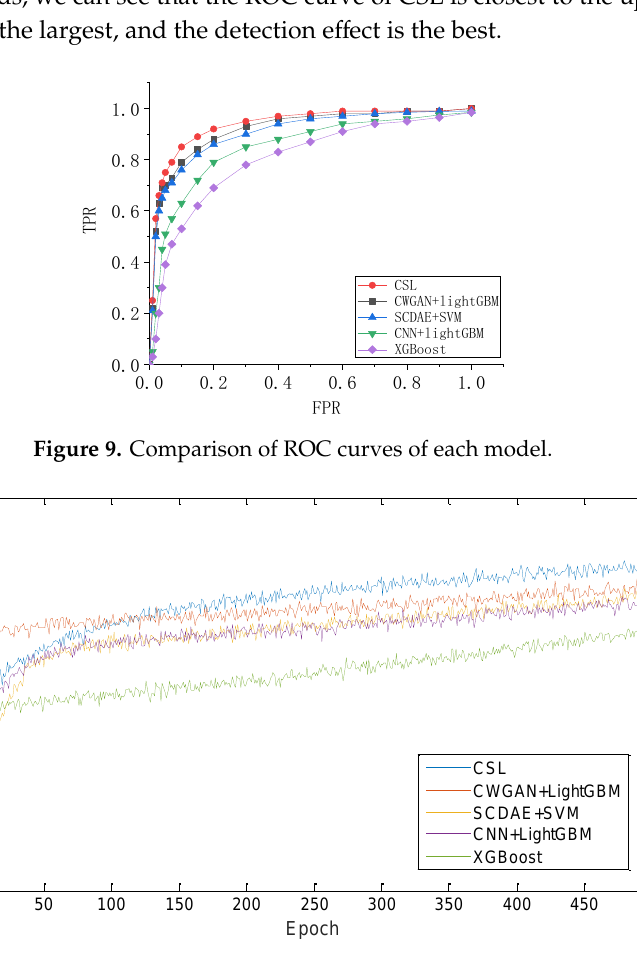
Figure 10. Comparison of iteration curves of each model.